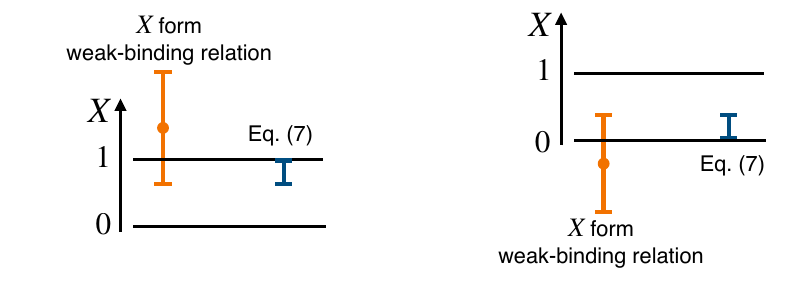
Figure 1. Schematic illustration of the definition of the uncertainty band (7). The left panel shows the case for X u > 1 ( ¯ X u = 1), and the right shows that for X l < 0 ( ¯ X l =